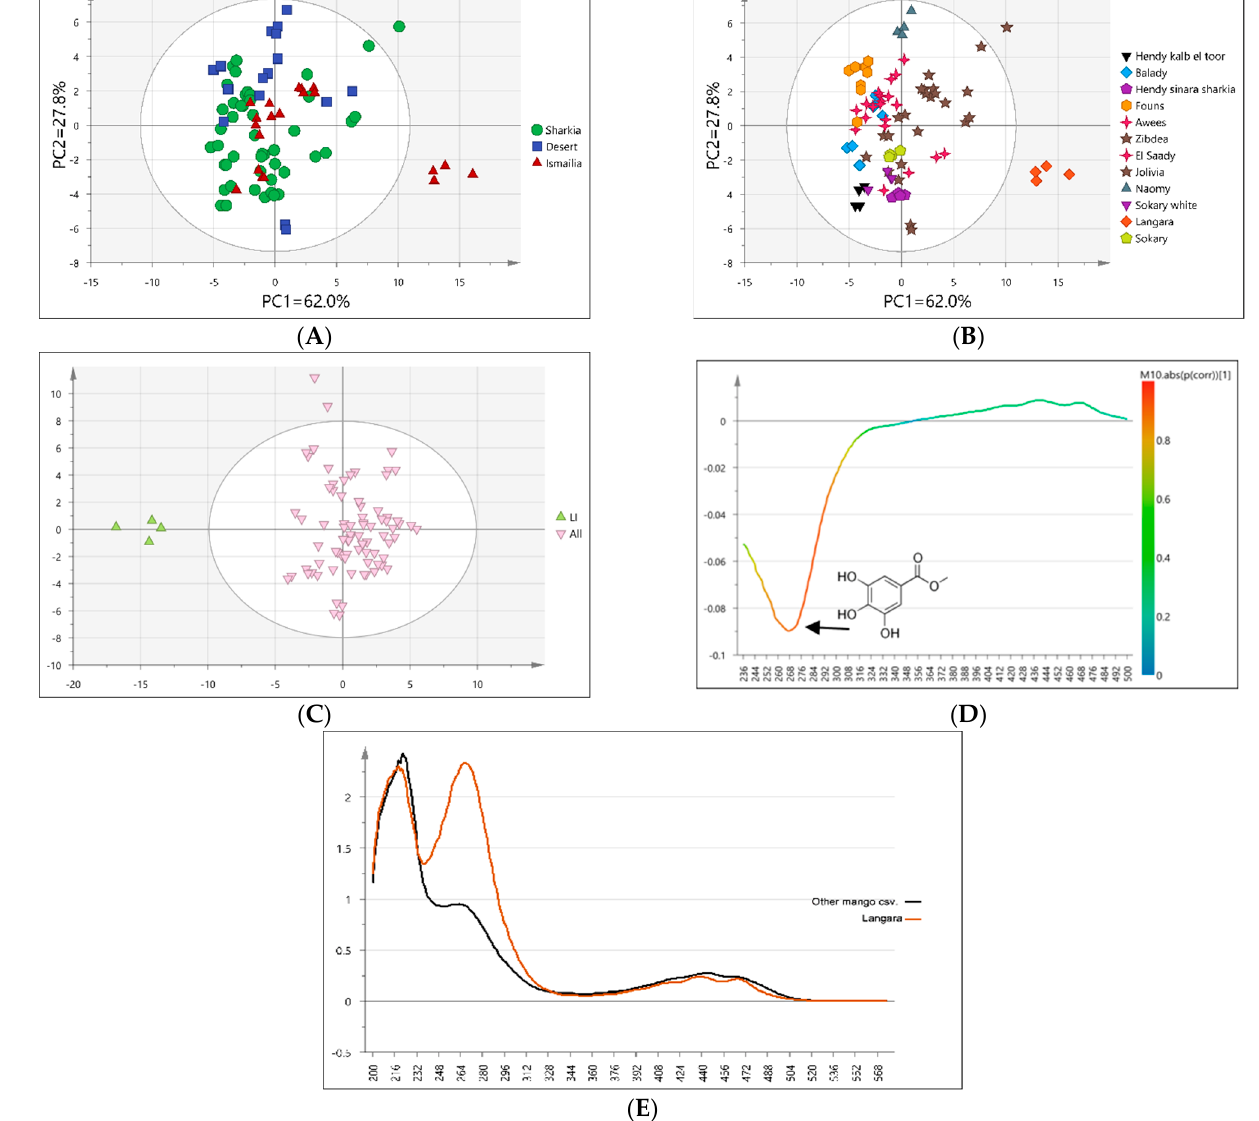
Figure 4. Unsupervised UV ‐ based PCA score plot of all mango accessions classified based on geographical origin ( A ) and cultivar ( B ). Supervised OPLS ‐ DA score plot of Langara cv versus all other Mango cvs. ( C ), corresponding S ‐ line plot ( D ), and UV spectrum of Langara vs. other mango cvs. ( E ).